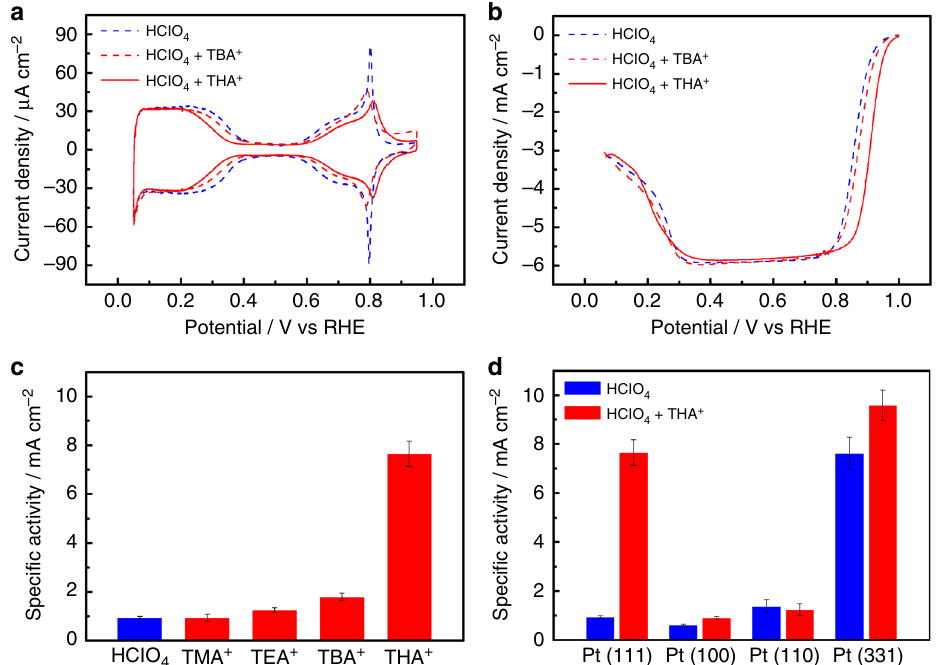
Fig. 1 Electrochemical characterization of platinum electrodes. a Cyclic voltammograms (CVs) and ( b ) linear sweep oxygen reduction reaction (ORR) voltammograms of Pt(111) in 0.1 M HClO 4 containing 10 − 5 M tetra- n -butylammonium cation (TBA + ) and 10 − 6 M tetra- n -hexylammonium cation (THA + ). CVs were measured in solutions saturated with Ar. The scanning rate is 0.050 V s − 1 . Linear sweep ORR voltammograms were obtained in the solutions saturated with O 2 , and the potential was scanned from 0.05 V in the positive direction. The scanning rate is 0.010 V s − 1 and the rotation rate of the electrode is 1600 rpm. c Speci fi c ORR activities of Pt(111) in 0.1 M HClO 4 containing 10 − 3 M tetramethylammonium cation (TMA + ), 10 − 3 M tetraethylammonium cation (TEA + ), 10 − 5 M TBA + , and 10 − 6 M THA + at 0.9 V versus reversible hydrogen electrode (RHE). d Speci fi c ORR activities of Pt (111), Pt(100), Pt(110), and Pt(331) = 3(111) ‒ (111) in 0.1 M HClO 4 with and without 10 − 6 M THA + at 0.9 V versus